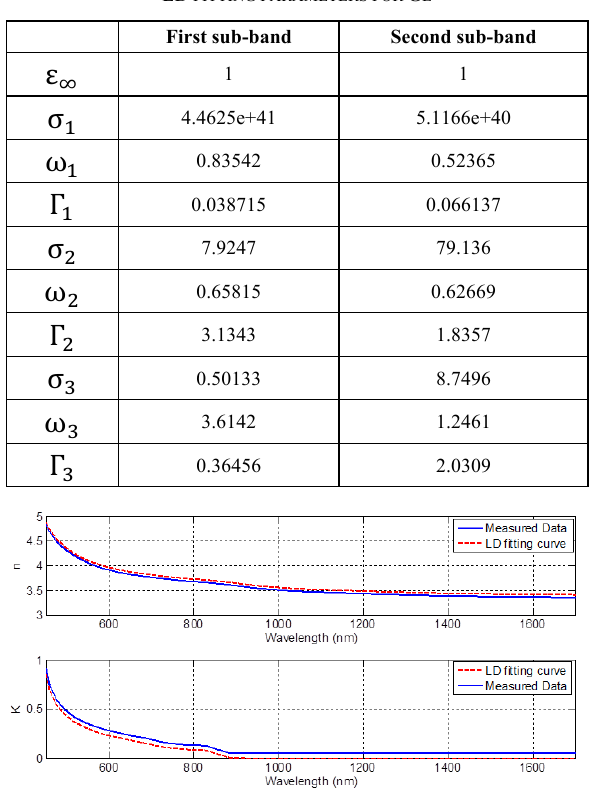
TABLE III. LD FITTING PARAMETERS FOR G E